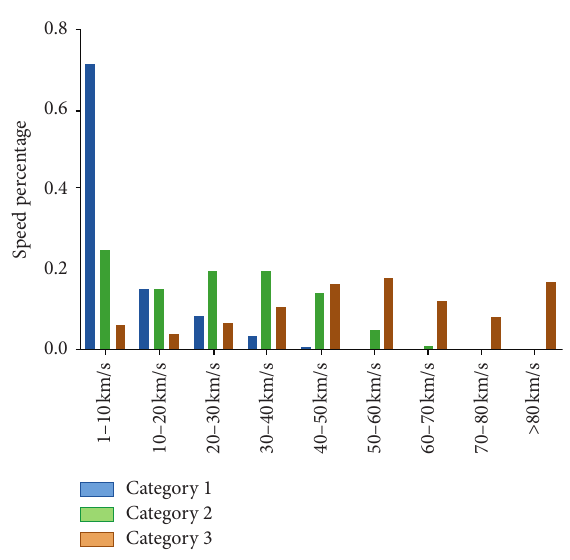
Figure 9: Distribution of speed in each category. Table 9: Comparison between constructed driving cycles and existing driving cycles.